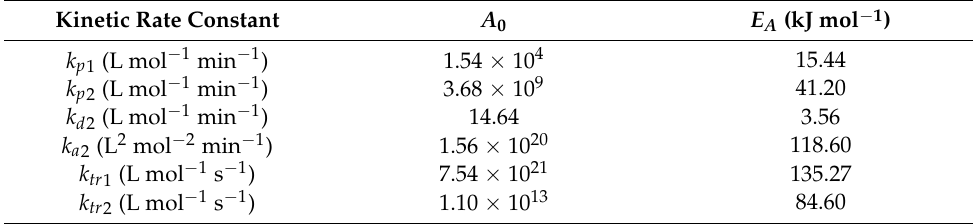
Table 8. Parameter estimation results of the PE polymerization using B3 = 5.53 × 10 − 4 mol L − 1 . Kinetic Rate